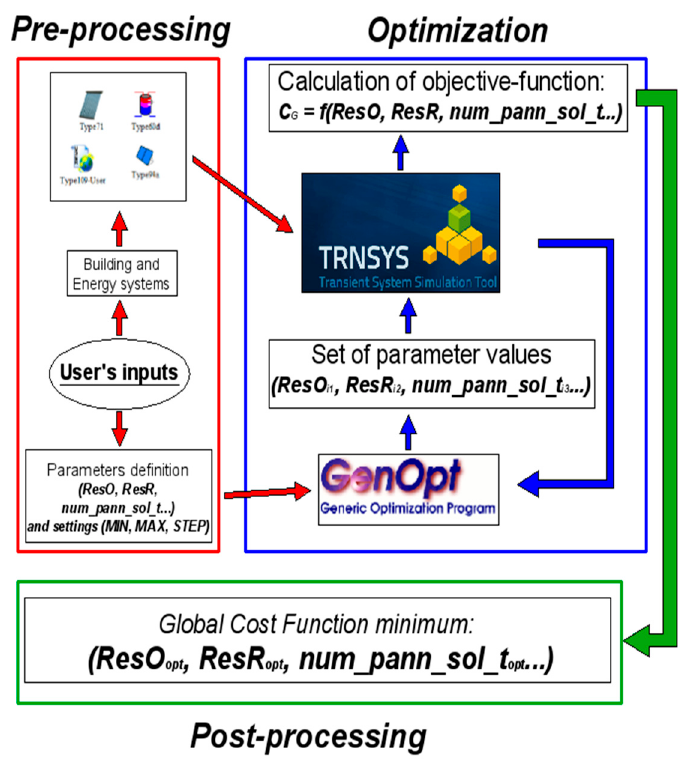
Figure 2. The main phases of the simulation-based optimization method.